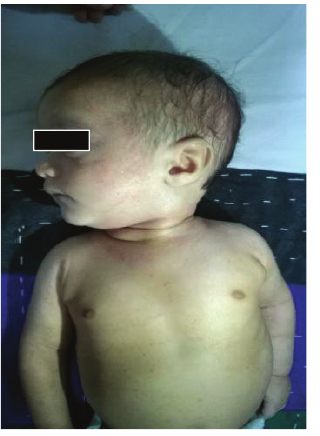
Figure 2: Showing maculopapular rash over baby’s face and